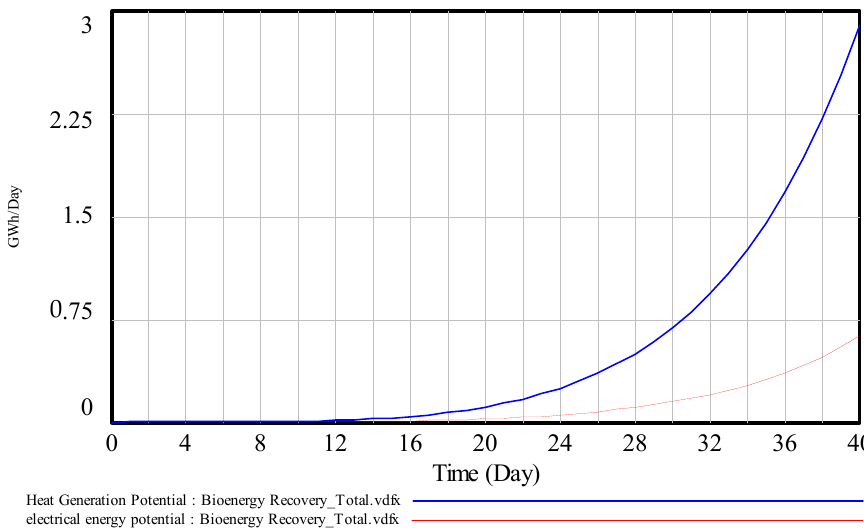
Figure 6. Power generation potential from the effluents produced.